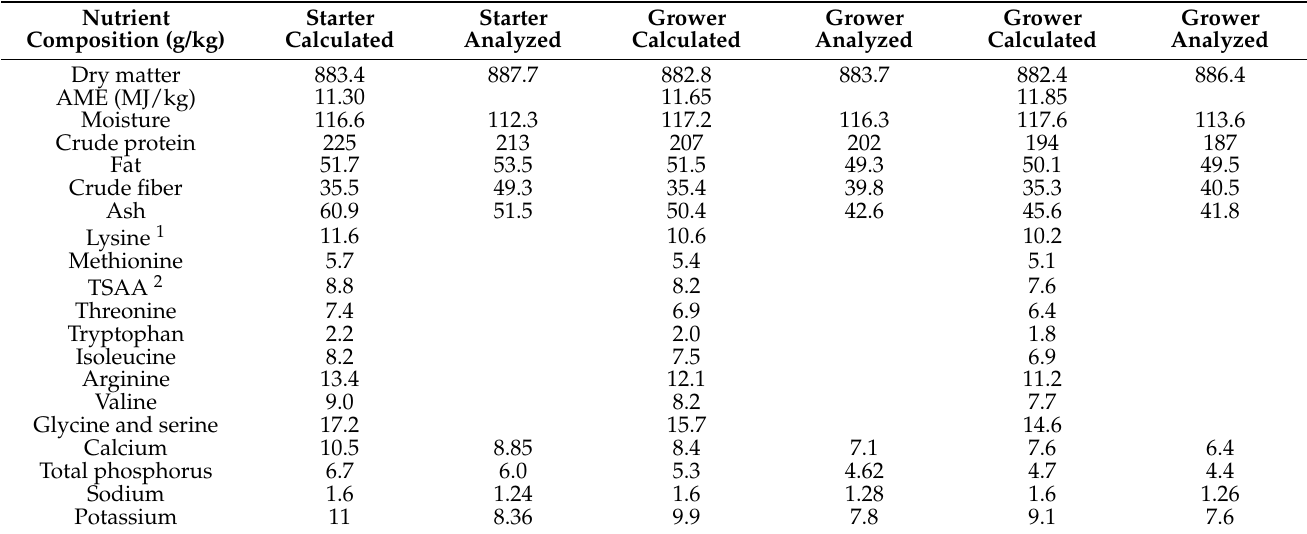
Table 12. Calculated and analyzed composition (g/kg) of the basal diets. Starter Calculated